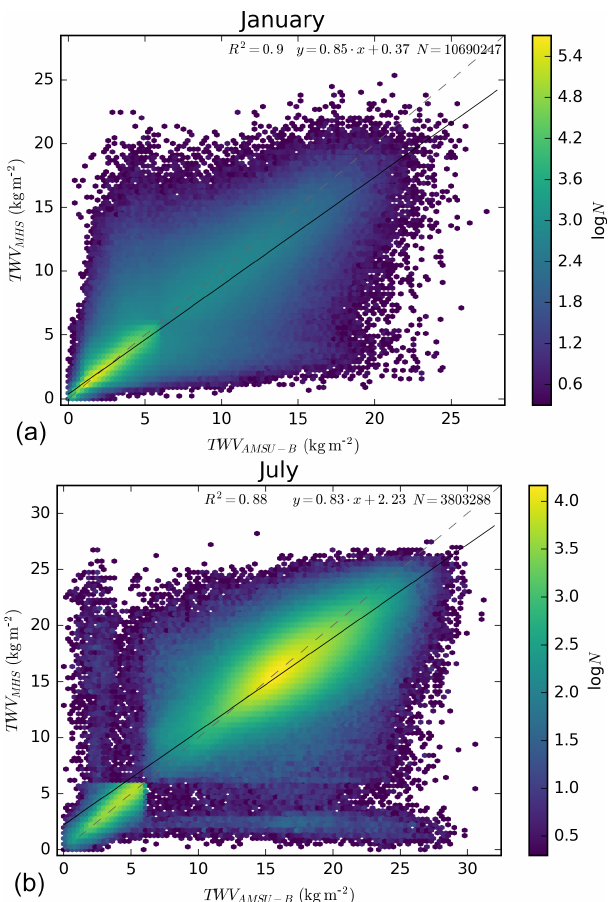
Figure 1. Density plot and fit for MHS TWV vs. AMSU-B TWV retrievals for all the coincident points in January (a) and July (b) , 2008–2010. The dashed line is the one-to-one line, and the black line corresponds to the linear fit of the